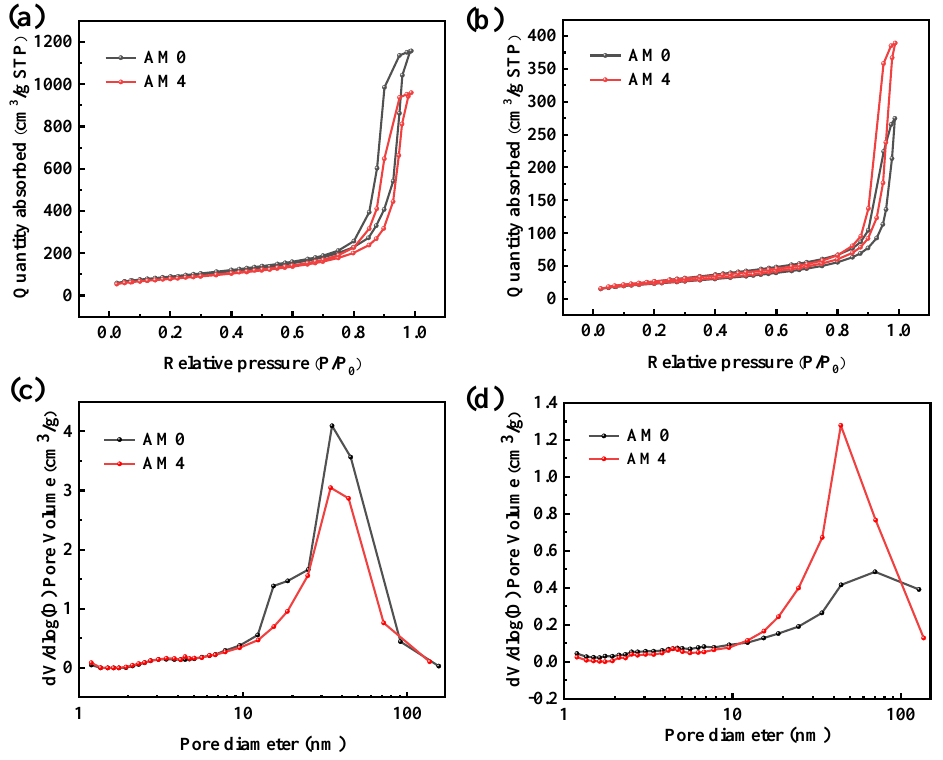
Figure 4. Nitrogen adsorption − desorption isotherms of AM0 and AM4 before ( a ) and after heat treatment at 1300 °C ( b ); Pore size distribution curves of AM0 and AM4 before ( c ) and after heat treatment at 1300 °C ( d ). Table 1. Specific surface area of samples as prepared and after heat treatment at 1300°C.